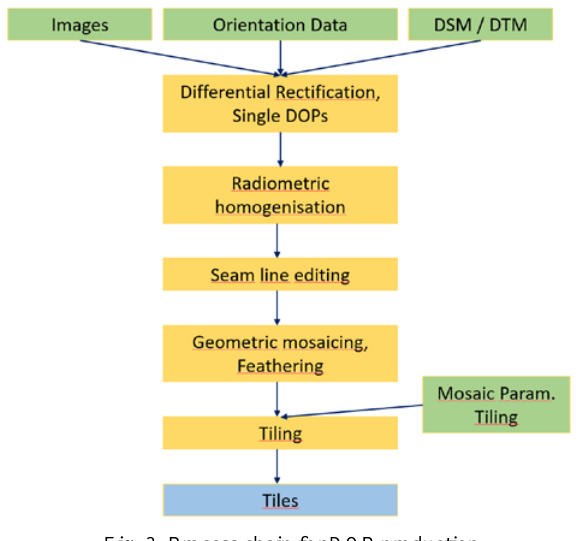
Fig. 3: Process chain for DOP production